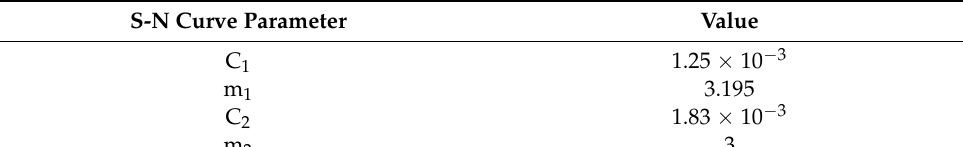
Table 1. S-N curve parameters [13].